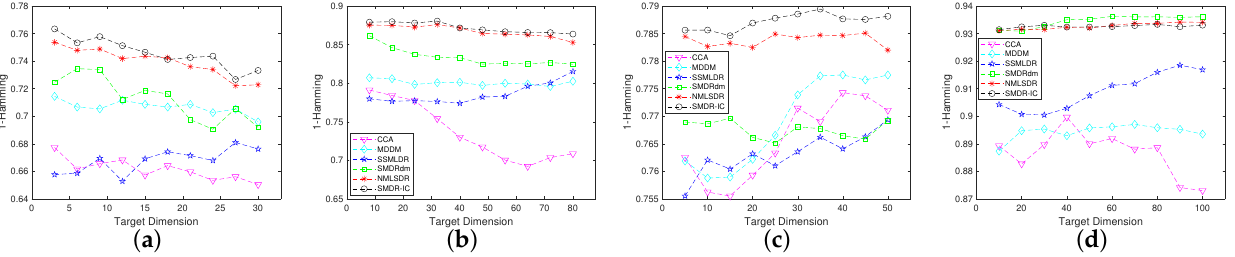
Figure 3. Results of 1-Hamming on four data sets under different target dimensionalities. ( a ) Emotions. ( b ) Scene. ( c ) Yeast. ( d ) Arts.